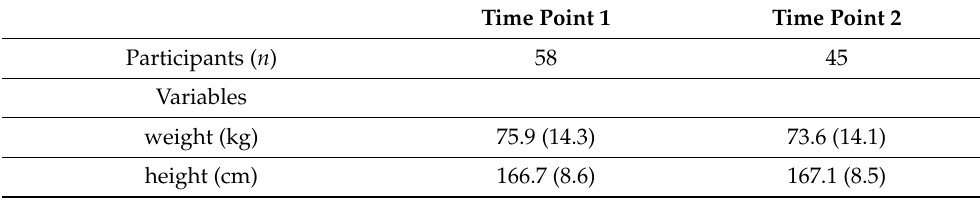
Table 1. Mean scores (and standard deviations) for health